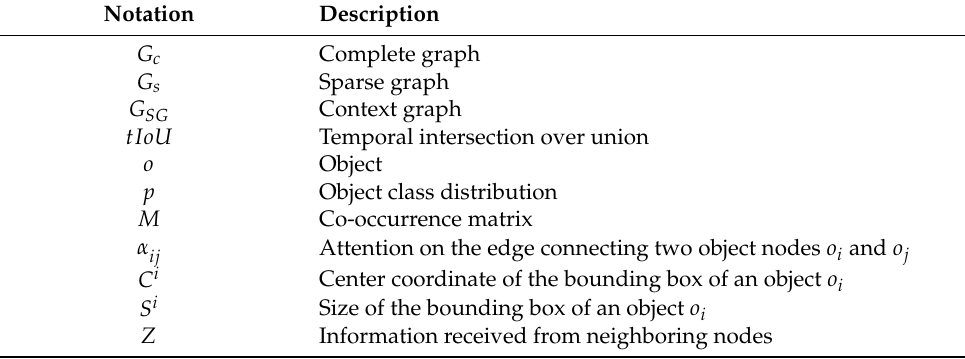
Table 1. Notation